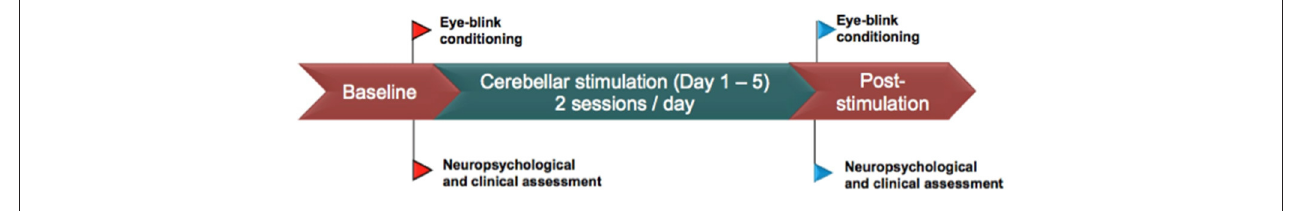
FIGURE 1 | Stimulation protocol and clinical assessment.